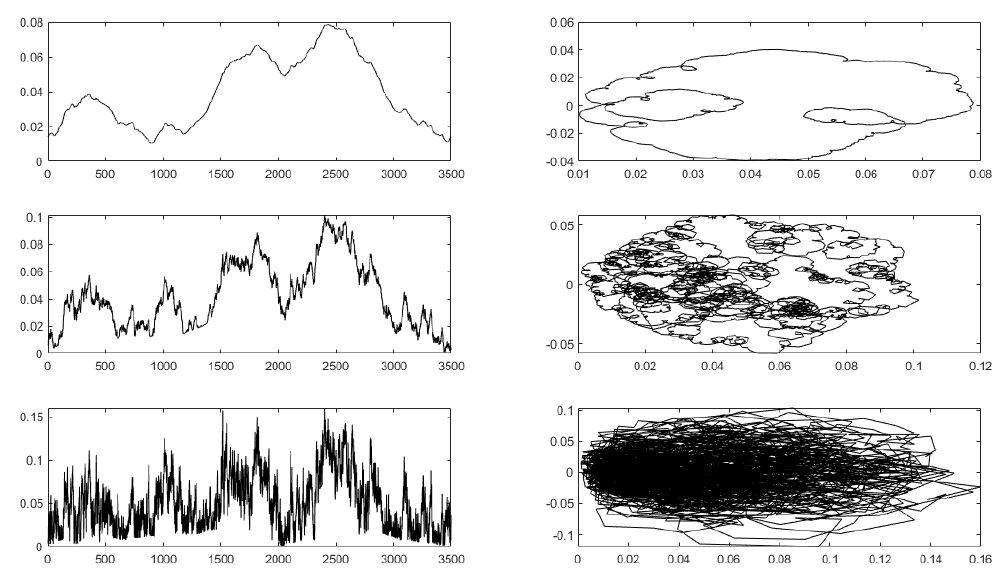
Figure 12. Examples of the function u n given by the discretised form of Equation (43) for γ = 1/2,1, and 3/2 (left plots, respectively) and the associated complex plane representations obtained using Equation (16)—right plots,